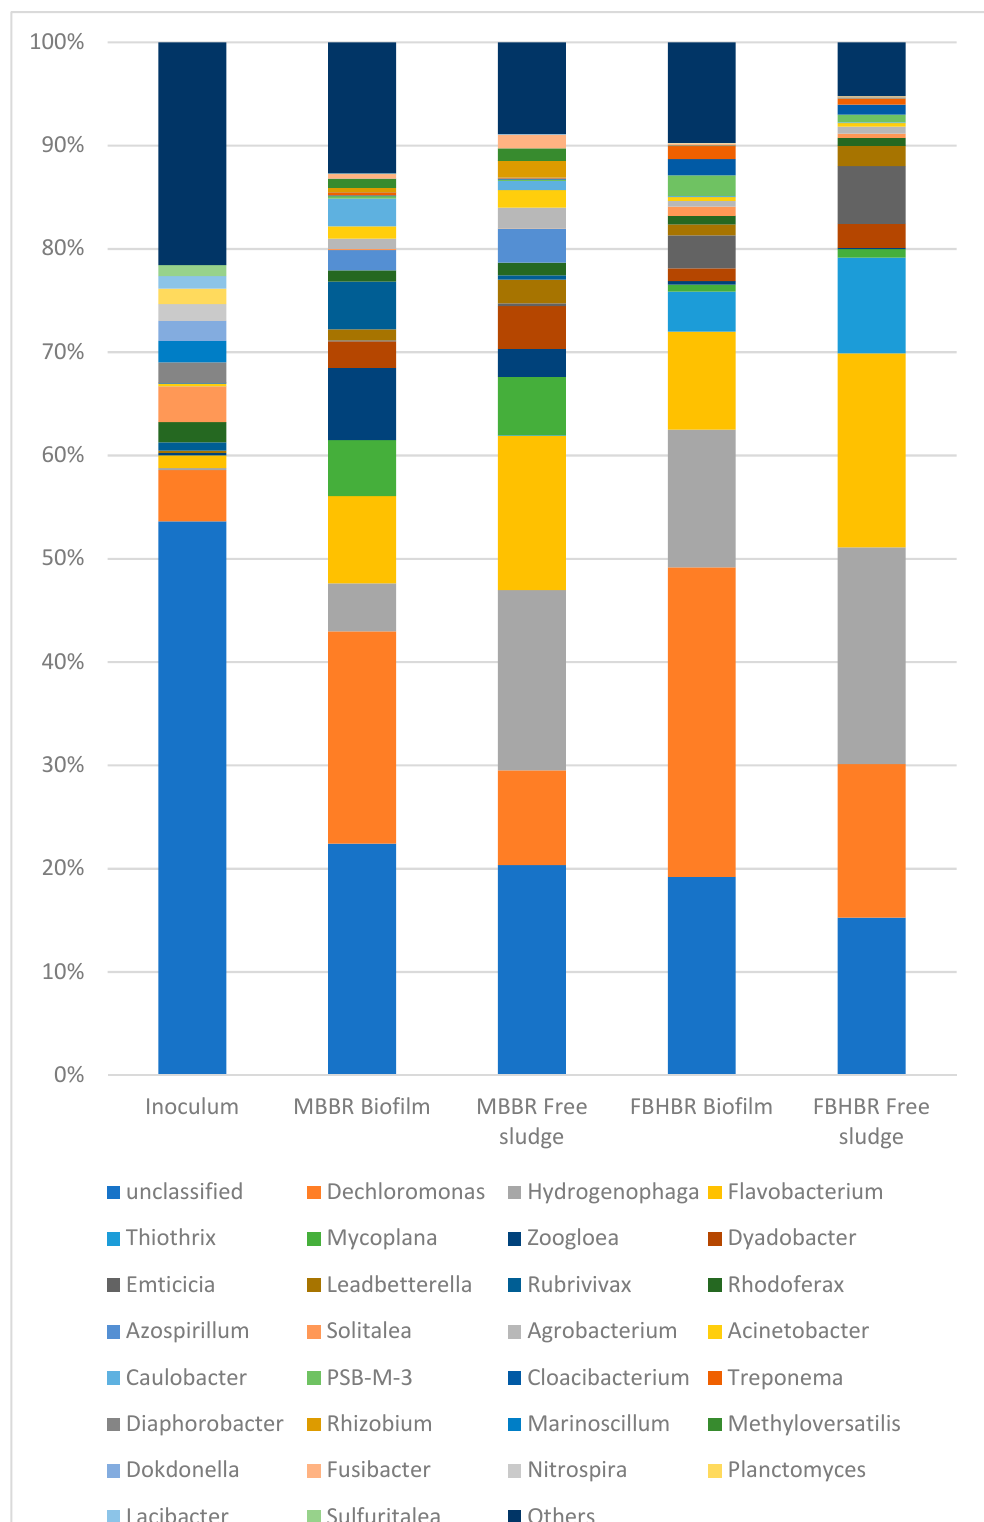
0%10%20%30%40% Figure 7. Bacterial assessment at the genus level in the MBBR and the FBHBR at TDS = 1.5 g·L − 1 .